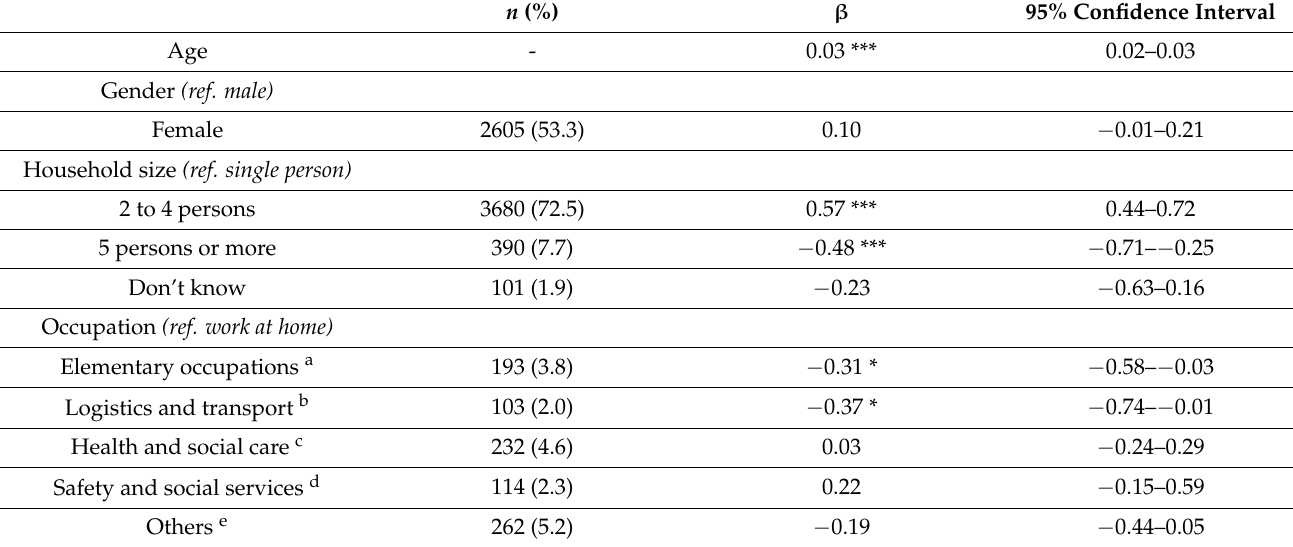
Table 1. Multiple linear regression models for Cantril Ladder scores among health and social determinants. n (%)